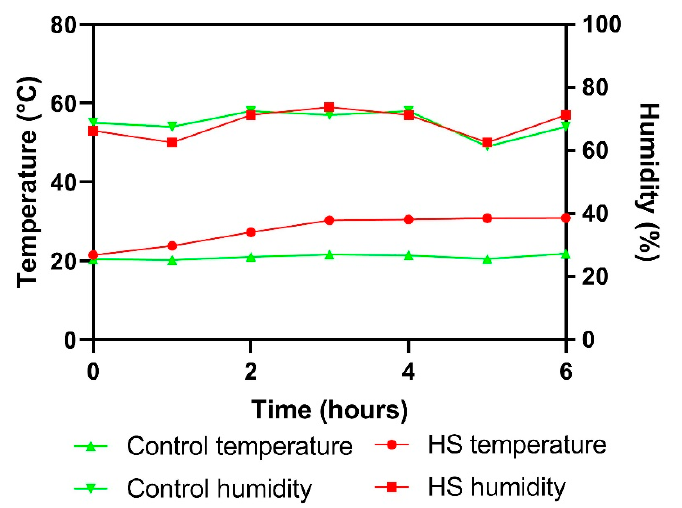
Figure 1. The temperature of thermoneutral control and heat stress rooms during the period of the experiment.